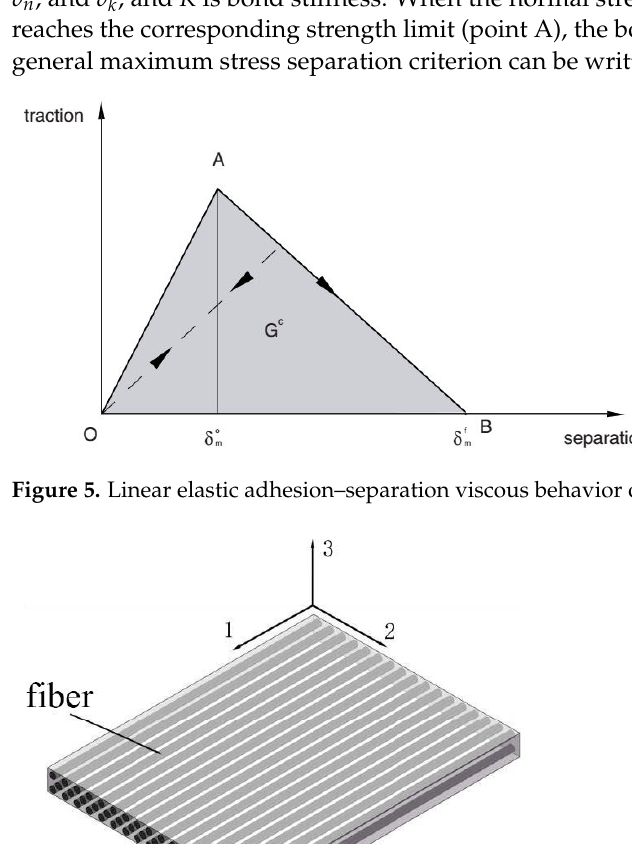
Figure 5. Linear elastic adhesion–separation viscous behavior of progressive damage failure.